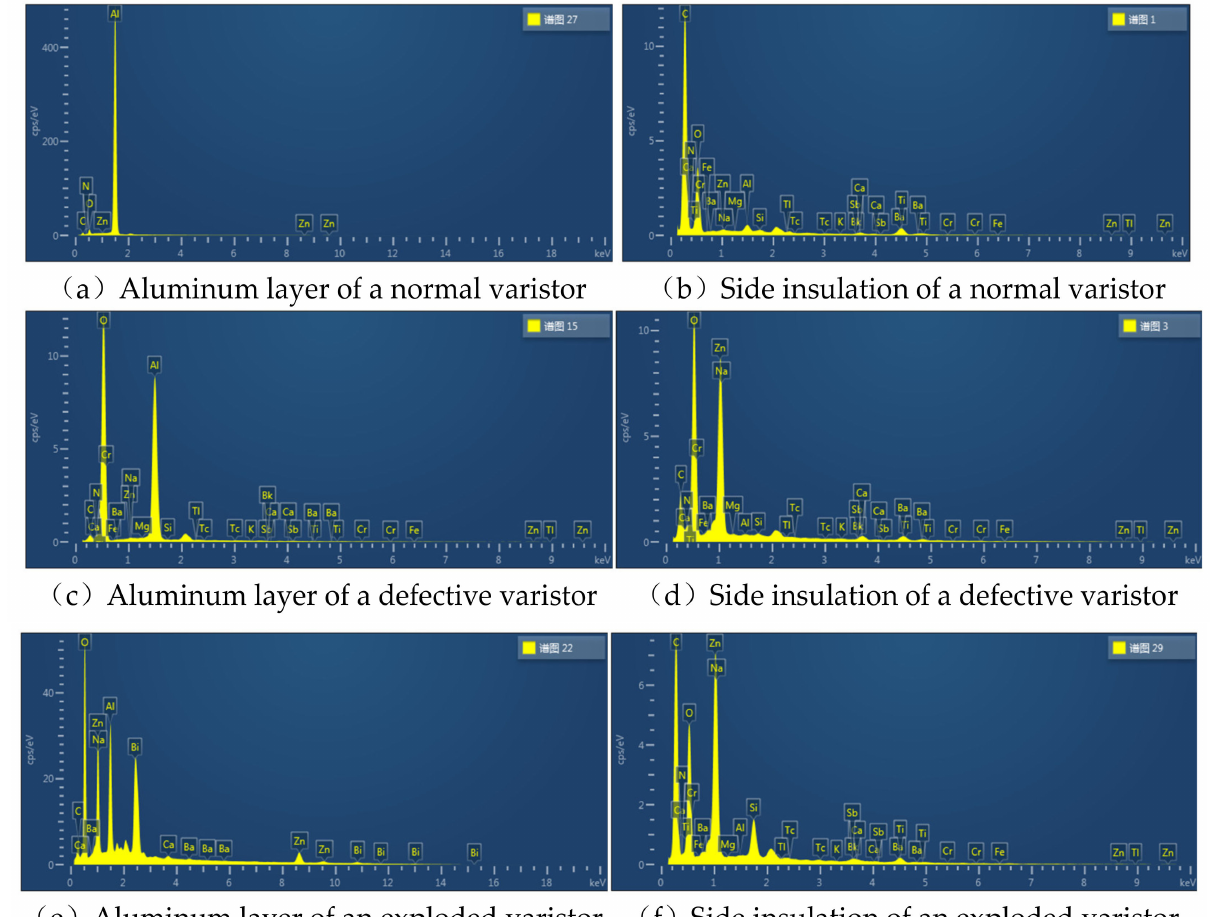
Figure 9. EDS test of arrester